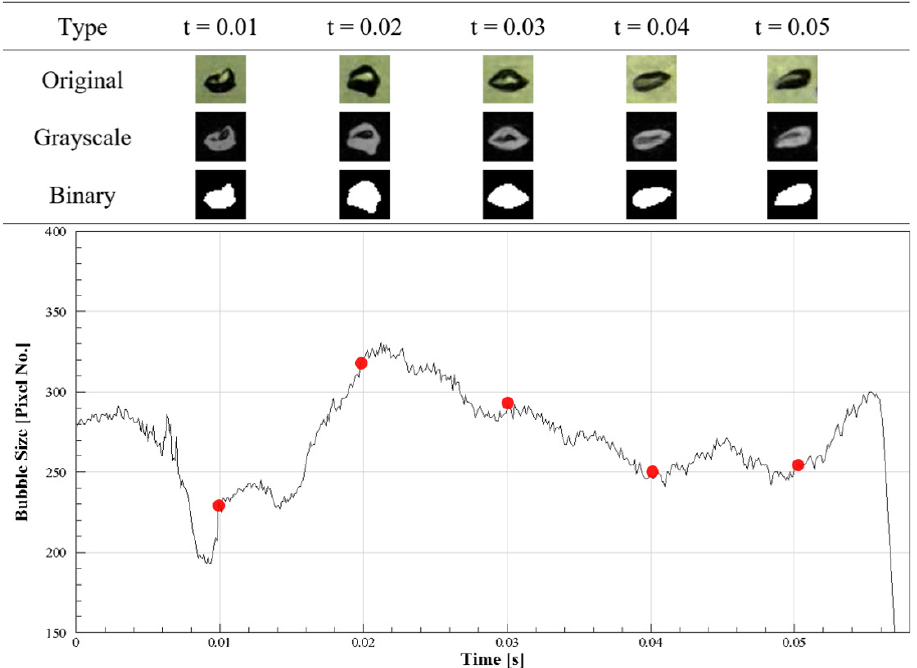
Figure 7. Bubble size in pixel over time, as it is advected with the free-stream (multimedia